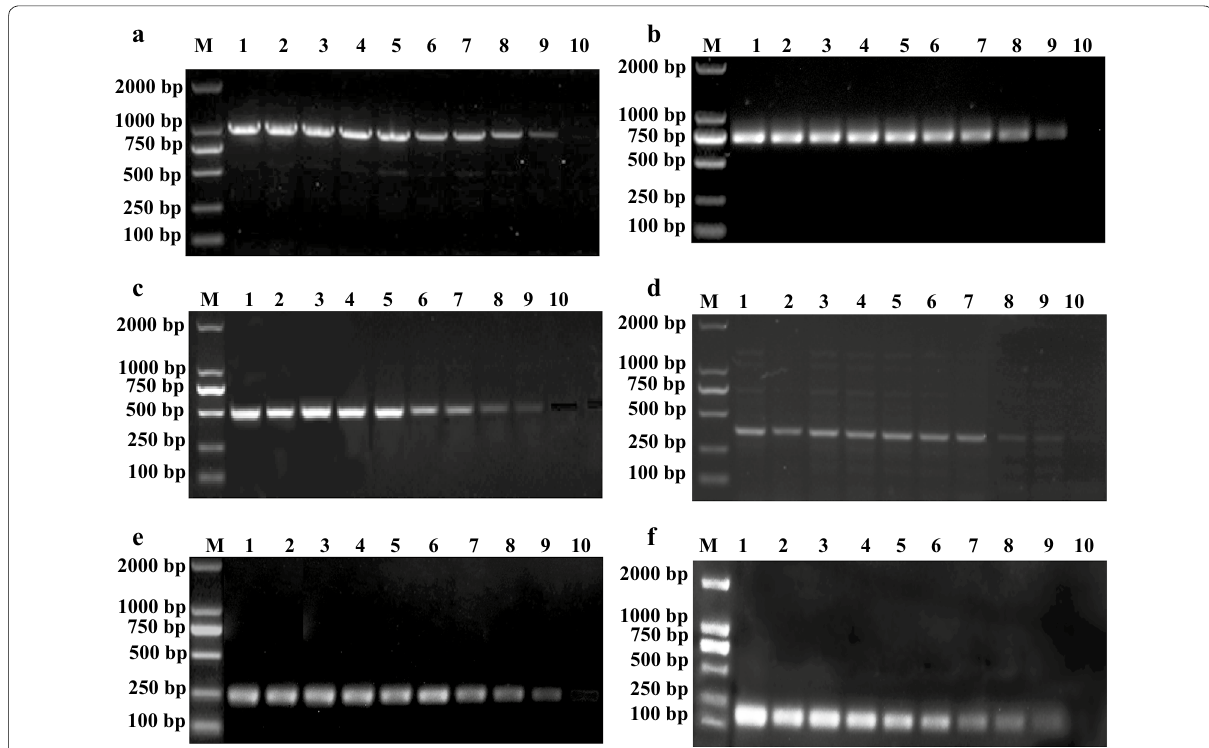
Fig. 5 Determination of the sensitivity of the multiplex PCR for bacterial genomic DNA detection. Lane M: 2000 bp DNA marker; a Lanes 1–10: the concentration of Escherichia coli DNA were 100 ng, 75 ng, 50 ng, 25 ng, 12.5 ng, 7.5 ng, 2.5 ng, 1 ng, 500 pg and 250 pg, respectively. b Lanes 1–10: the concentration of Pasteurella multocida DNA were 100 ng, 75 ng, 50 ng, 25 ng, 12.5 ng, 7.5 ng, 2.5 ng, 1 ng, 500 pg and 250 pg, respectively. c Lanes 1-8: the concentration of Proteus mirabilis DNA were 100 ng, 75 ng, 50 ng, 25 ng, 12.5 ng, 7.5 ng, 2.5 ng, 1 ng, 500 pg and 250 pg, respectively. d Lanes 1–10: the concentration of Pseudomonas aeruginosa DNA were 100 ng, 75 ng, 50 ng, 25 ng, 12.5 ng, 7.5 ng, 2.5 ng, 1 ng, 500 pg and 250 pg, respectively. e Lanes 1–10: the concentration of Salmonella spp. DNA were 100 ng, 75 ng, 50 ng, 25 ng, 12.5 ng, 7.5 ng, 2.5 ng, 1 ng, 500 pg and 250 pg, respectively. f Lanes 1–10: the concentration of Staphylococcus aureus DNA concentration were 100 ng, 75 ng, 50 ng, 25 ng, 12.5 ng, 7.5 ng, 2.5 ng, 1 ng, 500 pg and 250 pg,